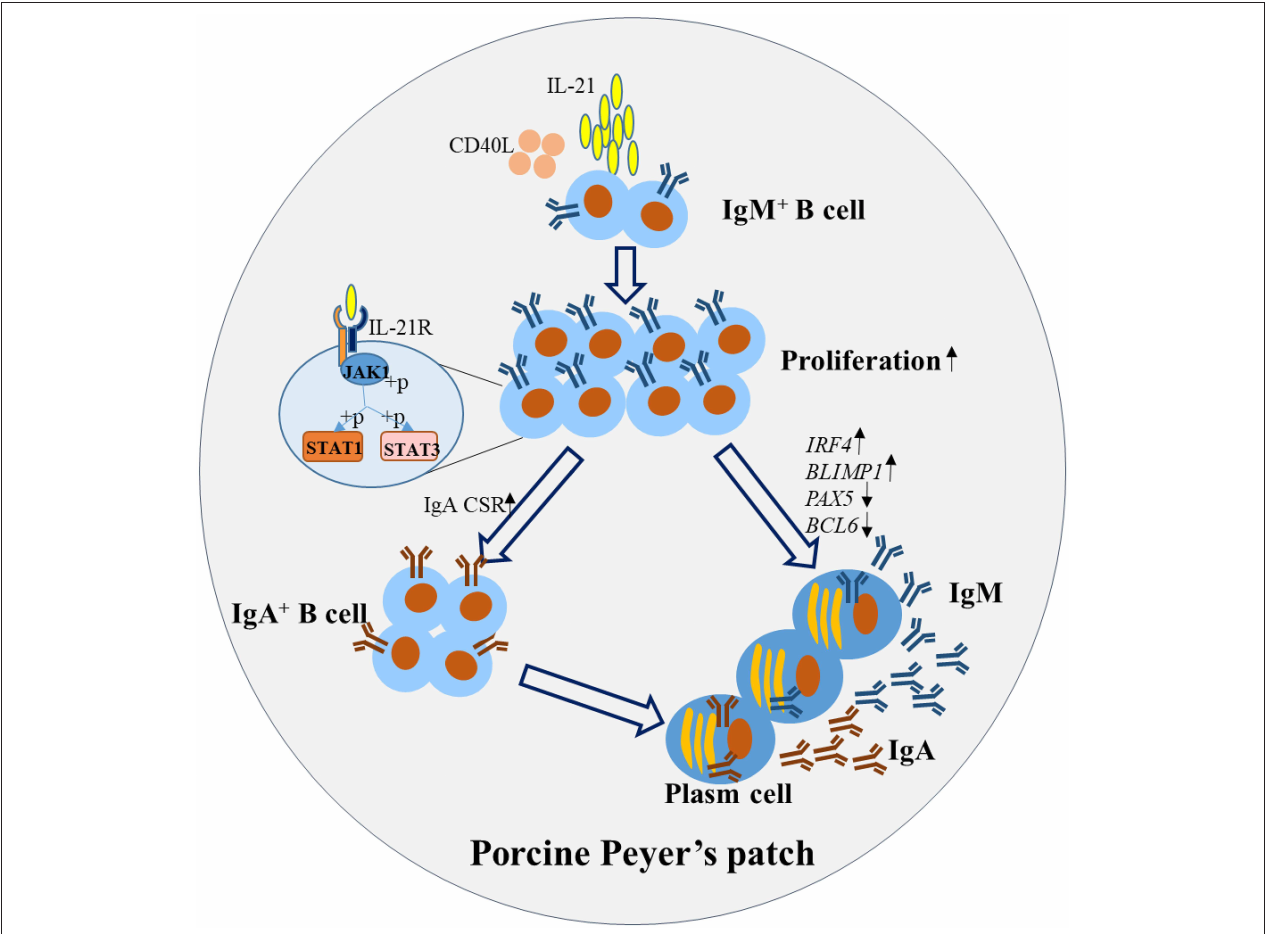
FIGURE 7 | Proposed working model for IL-21-induced B cell differentiation and IgA-producing plasma cells in porcine Peyer’s patches. IL-21 binds to the IL-21R on B cells, promotes the proliferation and inhibits the apoptosis. IL-21 increased IgA CSR, through the phosphorylation of JAK1, STAT1, and STAT3 leading to the production of IgA + B cells. Additionally, IL-21 promoted the differentiation of plasma cells, characterized by increased expression of BLIMP1 and IRF4 and decreased expression of PAX5 and BCL6 . Thus, IgA was robustly produced by the IgA-secreting B cells in porcine Peyer’s